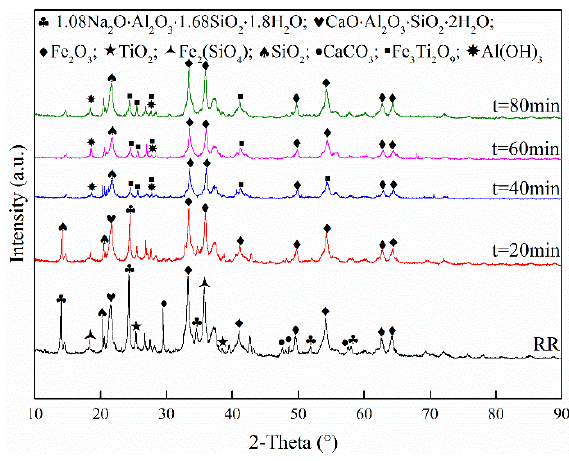
Figure 9. XRD of the raw red mud desulfurization process.